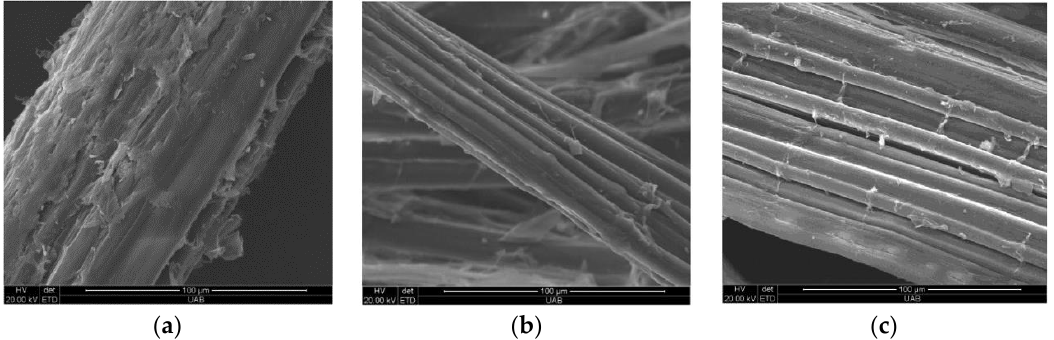
Figure 5. The alkalization effect on fibrillation of hemp fiber: ( a ) raw, ( b ) 5 wt. % NaOH and ( c ) 10 wt. % NaOH. Reproduced with permission from [119].